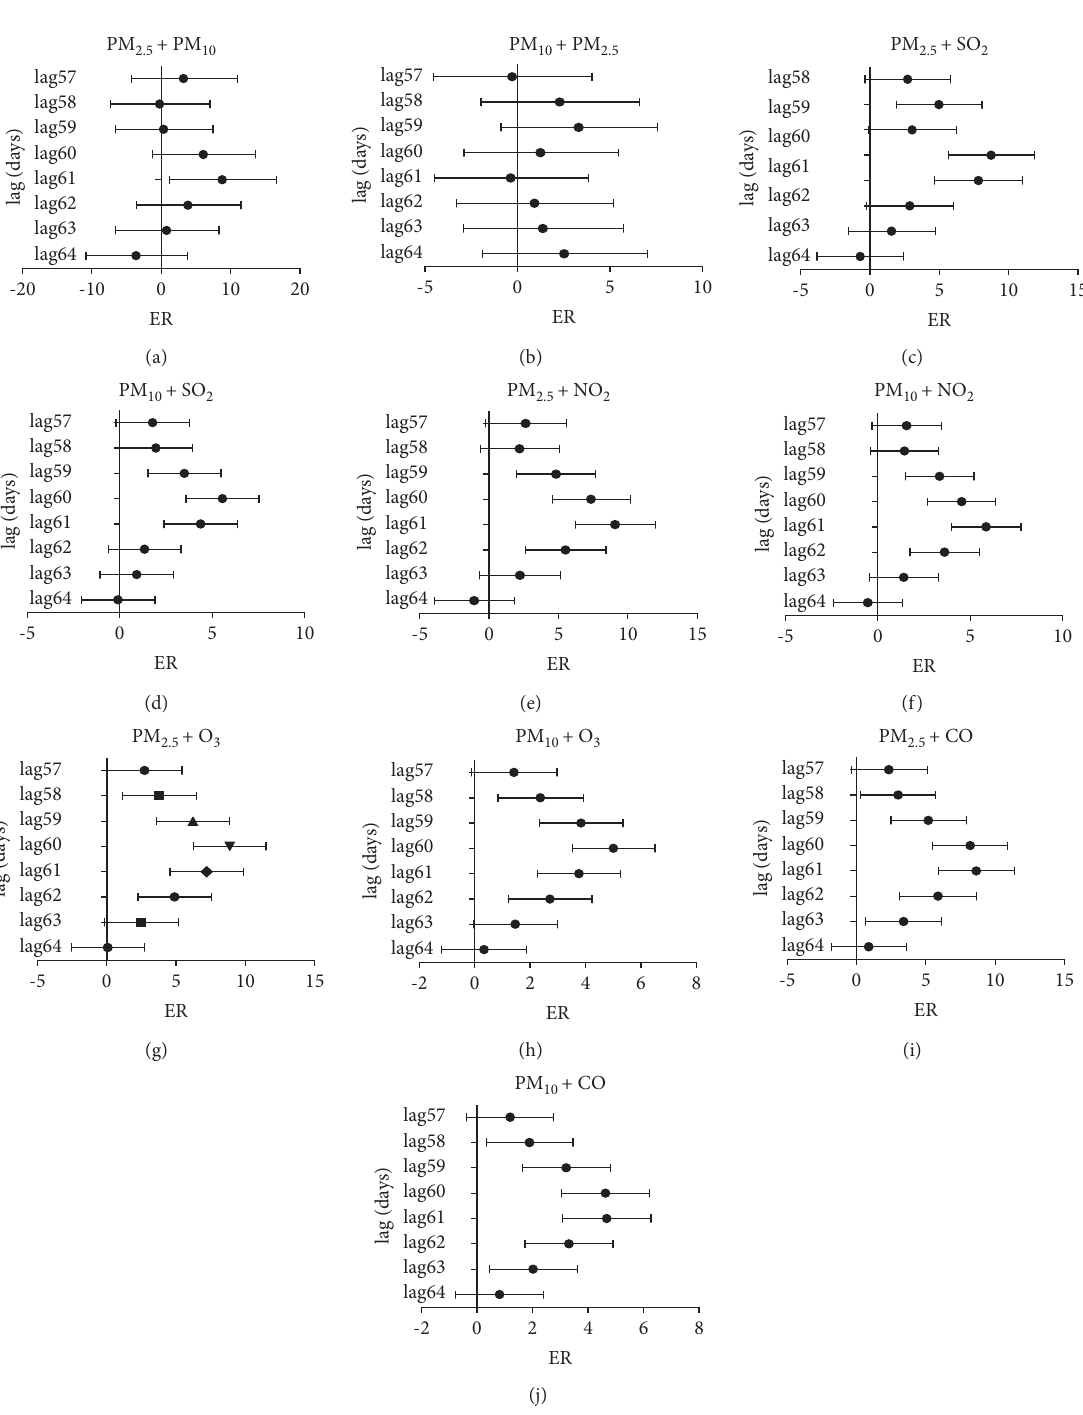
Figure 4: Excess risk (ER) with 95% confidence intervals in daily hypertension hospital admissions associated with 10 μ g/m 3 increase in PM 2.5 and PM 10 concentrations in two-pollutant models: (a) after adjusting for PM 10 , excess risk (ER) in daily hypertension